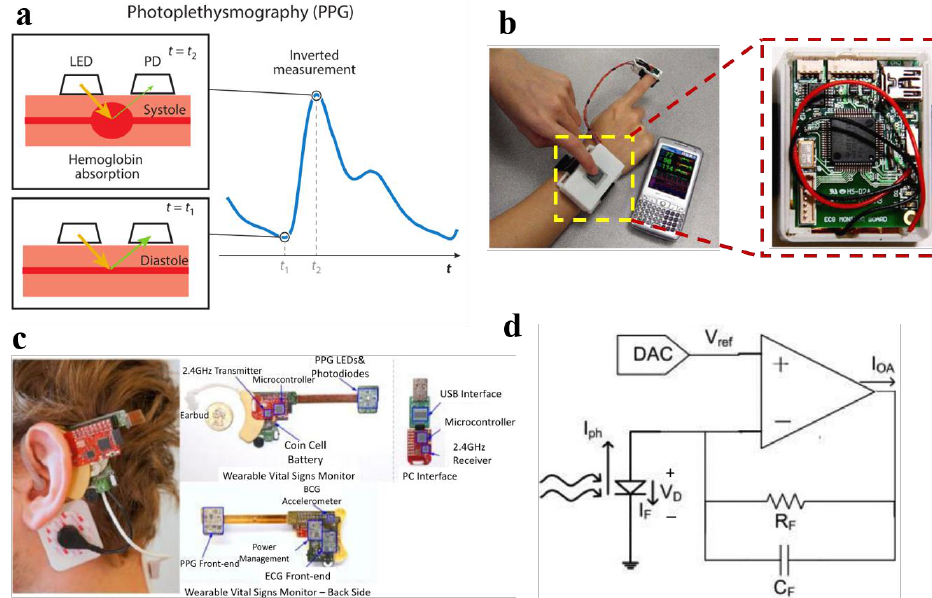
Figure 3. ( a ) PPG technology. Abbreviations: LED, light-emitting diode; PD, photodetector; Repro- duced with the permission of [27]. Copyright 2022, Annual Reviews. ( b ) The wrist-worn device and phone display; Reproduced with the permission of [53]. Copyright 2010, IEEE. ( c ) Wearable vital signs monitor worn at the ear; ( d ) Static photocurrent subtraction circuit. Reproduced with the per- mission of [55]. Copyright 2012, IEEE.